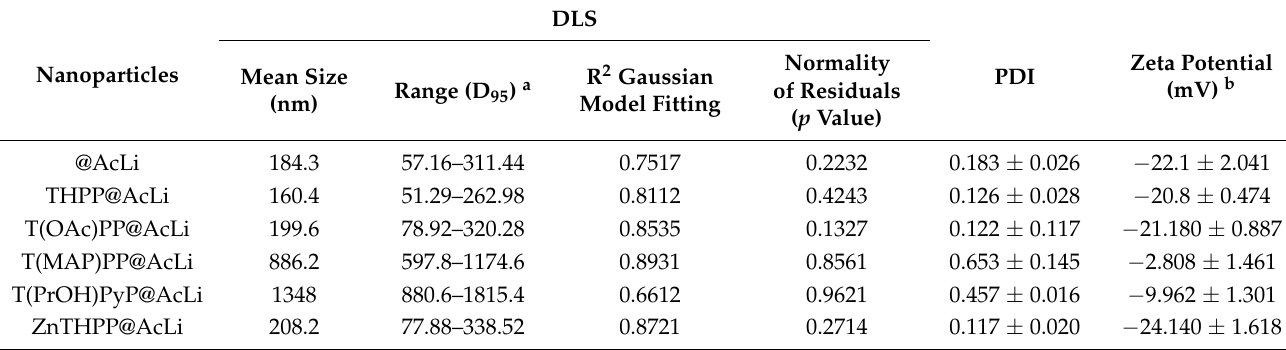
Table 1. Physical characteristics of